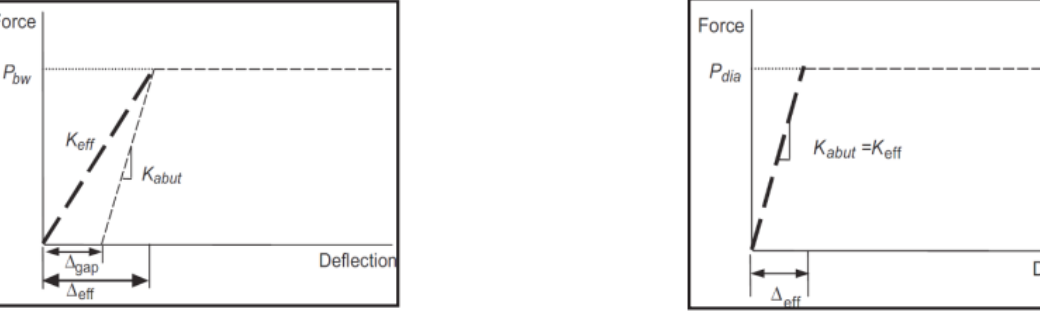
Fig. 5. Abutment force -displacement changes with expansion joint and continuous abutment with deck [11].